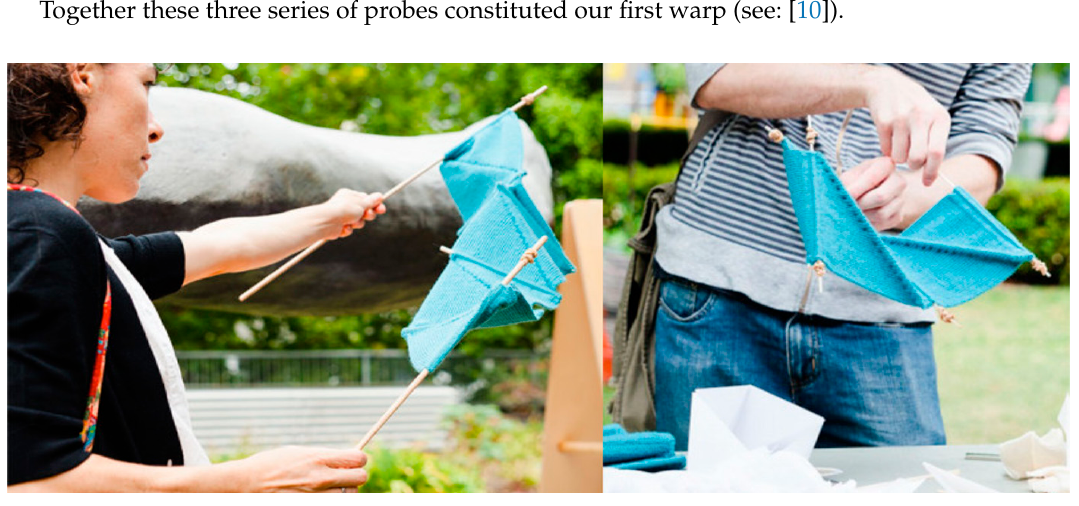
Figure 1. Loom 1 probe-set (1): Green Knits .